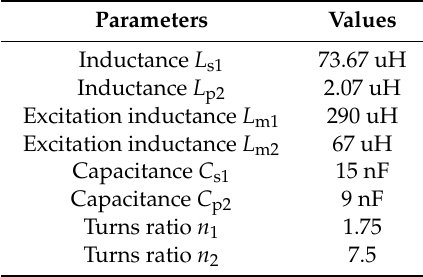
Table 1. Main parameters of the proposed converter.